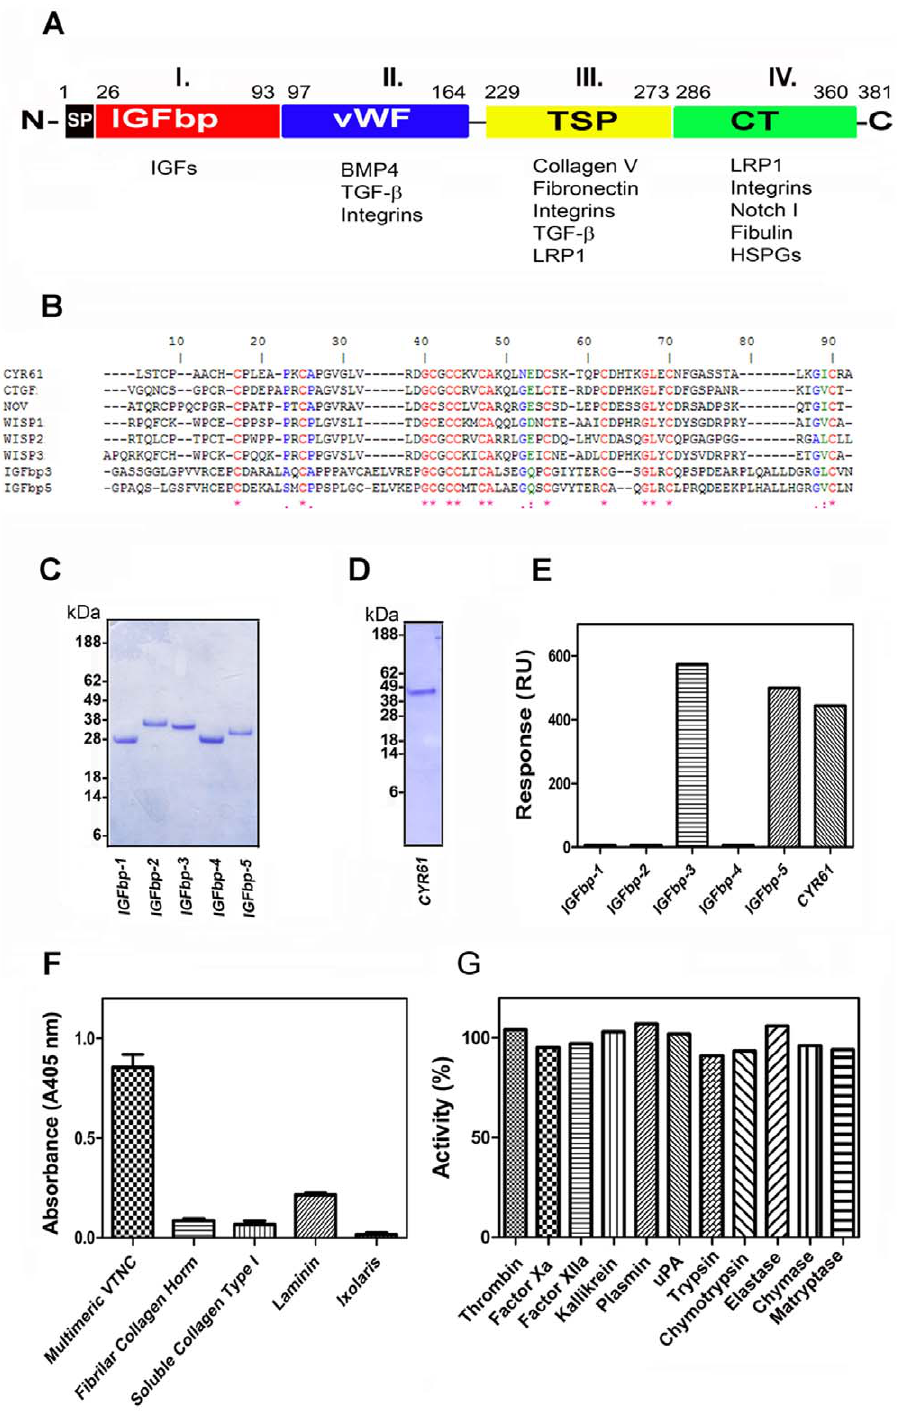
Figure 1. Cyr61 binds to VTNC. ( A ) Structure of CCN family members. CCN1 (Cyr61, represented in the figure), CCN2 (CTGF), CCN3 (NOV), CCN4 (WISP-1), CCN5 (WISP-2), and CCN6 (WISP-3) have a shared structure consisting of a secretory signal peptide (SP), an IGFBP domain (Module I), a von Willebrand type C domain (vWC, Module II), a thrombospondin-1 domain (TSP, Module III) and a cysteine knot (CT, Module IV) domain. Domains are linked by hinge regions susceptible to protease cleavage. Modified from reference [3]. ( B ) Clustal alignment of CCN family members with IGFBP-3 and -5 indicates several conserved residues (*). ( C ) and ( D ) SDS-PAGE for IGFBP-1 to -5, and Cyr61, respectively. Two m g of proteins were loaded in a 4– 12% NU-PAGE gel, which was Coomassie blue stained. ( E ) SPR experiments: proteins (100 nM) were used as analytes for immobilized VTNC. Binding levels at stability was used as a value for comparison. RU, resonance units. ( F ) Specificity of Cyr61 (30 nM) tested by solid-phase binding assays: proteins were immobilized as the following densities/well: VTNC (25 ng), fibrilar collagen (50 ng), ixolaris (75 ng), soluble collagen and laminin (100 ng), followed by incubation with Cyr61 (30 nM). Bound-Cyr61 was identified using anti-Cyr61 monoclonal antibody. ( G ) Cyr61 does not inhibit enzyme activity. Cyr61 (300 nM) was incubated with different enzymes and fluorogenic substrate hydrolysis was followed as indicated in Materials and Methods. SEM are not depicted but were less than 5% (n=3).